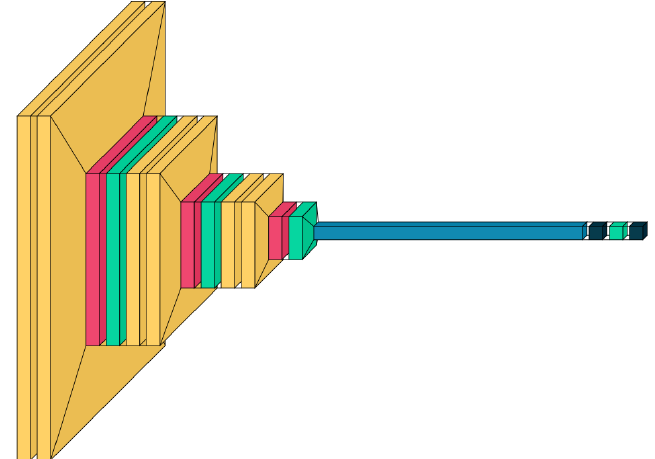
Fig. 3. Visual representation of the layers of Model 2 Yellow = Convolutional layer; Red = Max Pooling layer; Green = Dropout layer; Blue = Flatten layer; Dark blue= Dense